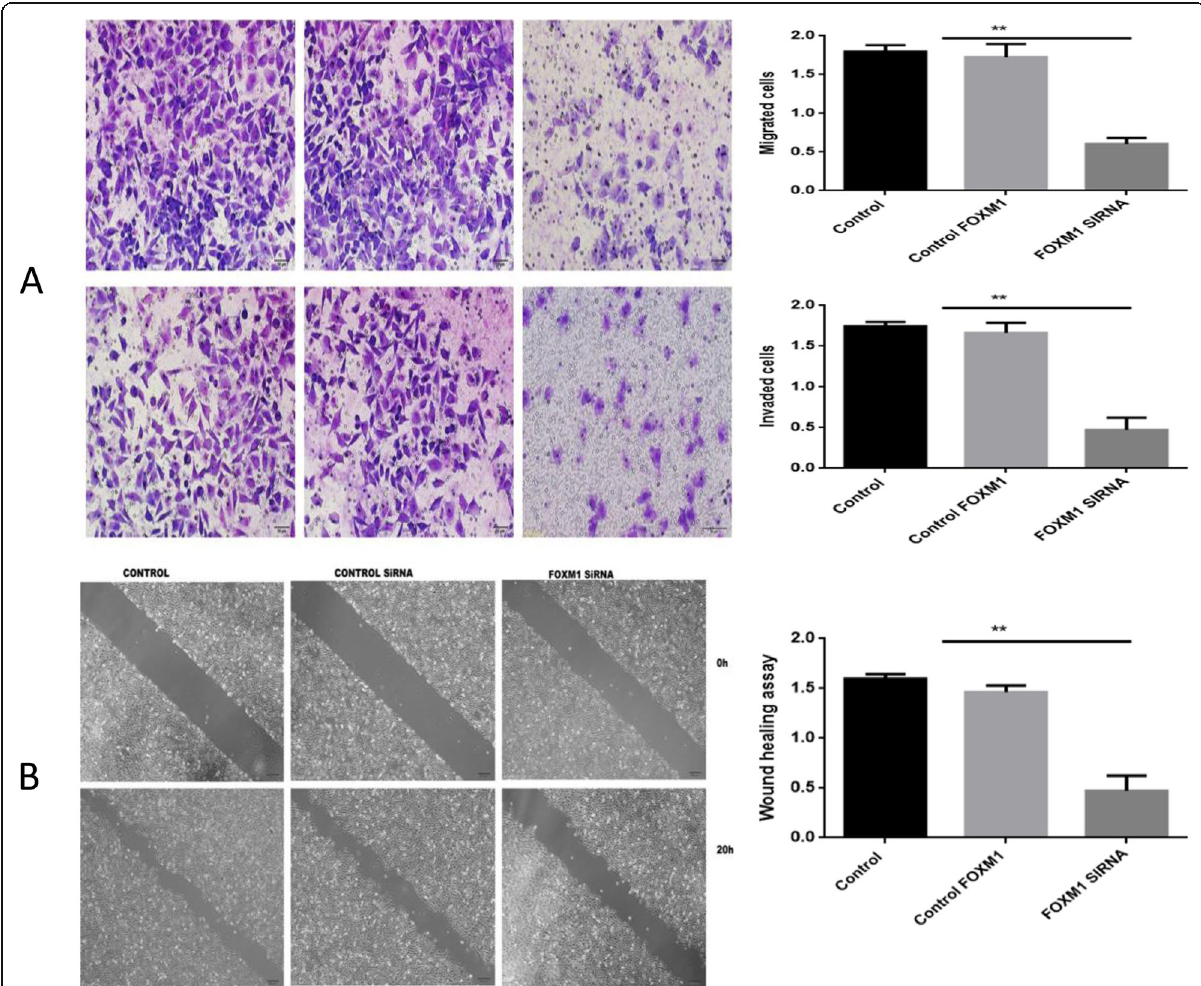
Fig. 6 a Top panel: Migration and invasion assays following FoxM1 silencing. Bottom panel: Quantitative results are shown for panel. * * P <0.01 vs control (× 200); b Top panel: Wound healing assays to measure the migratory capacity in three groups of EC cells after FoxM1 silencing. Bottom panel: quantitative analysis. ** P <0.01 vs